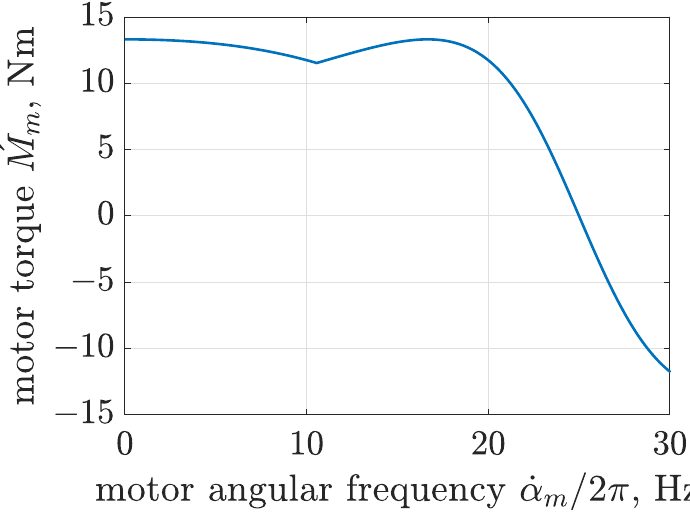
Figure 4. Characteristics of the electric motor model based on switchable Kloss